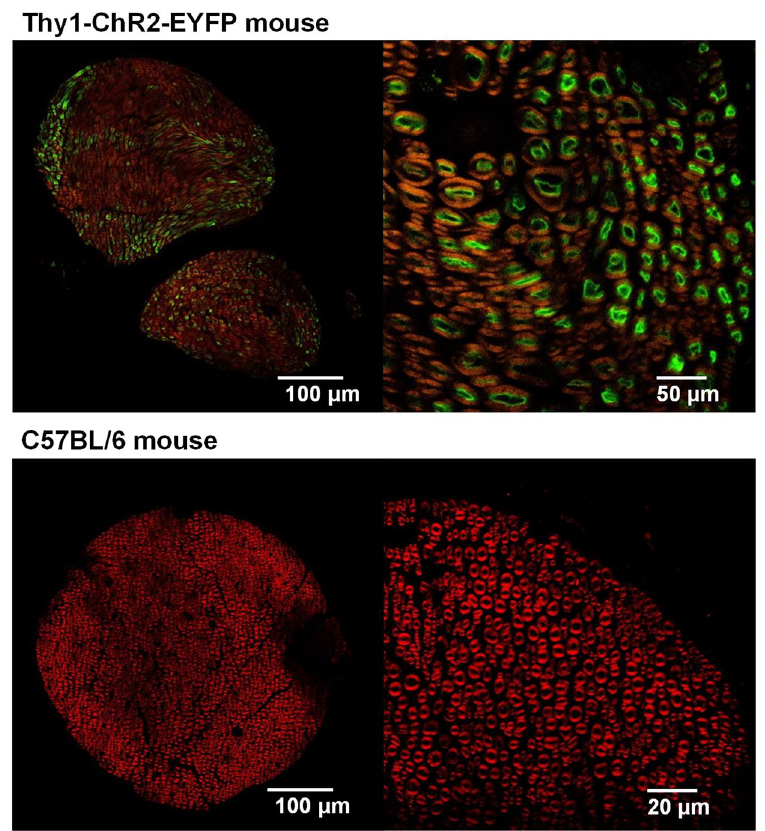
Figure 8. ChR2 expression in the sciatic nerve of a Thy1::ChR2 mouse. Confocal image of the sciatic nerve in a Thy1::ChR2 mouse and a C57BL/6 mouse. Motor neurons expressing ChR2-EYFP (green) and FluoroMyelin (red). Myelin (red) surrounds the neurons (green) in the Thy1::ChR2